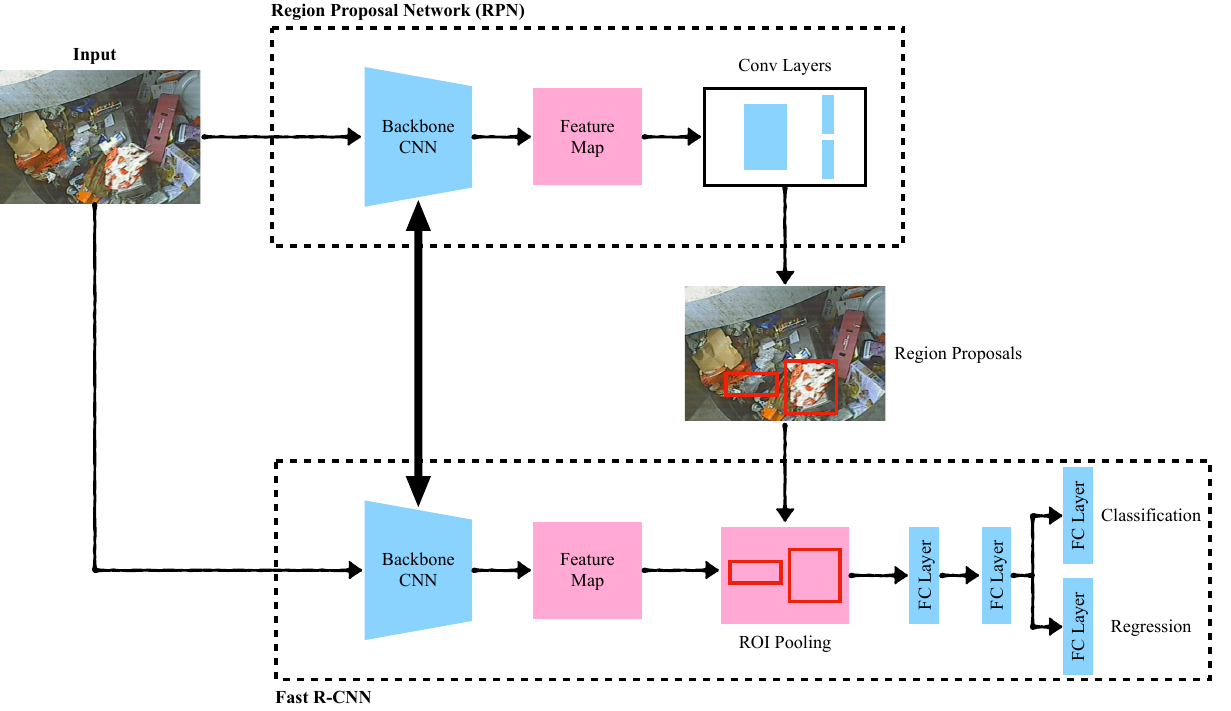
Figure 3. Overview of Faster R-CNN